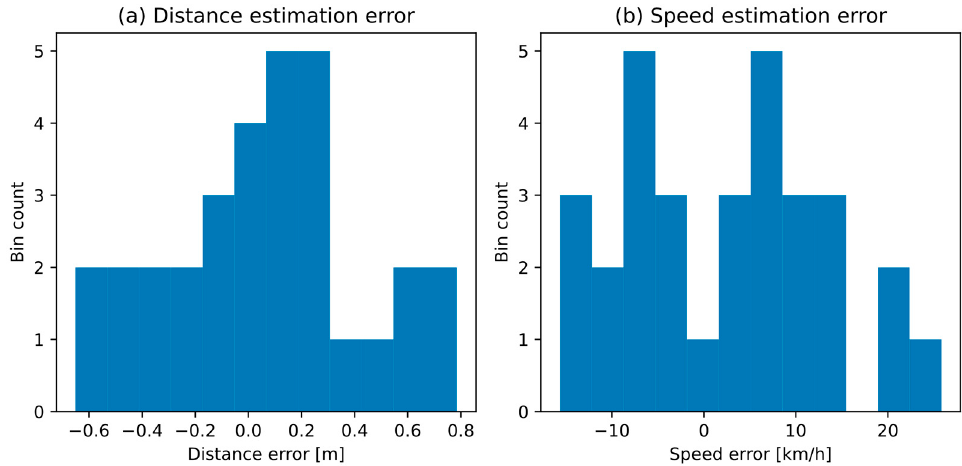
Figure 11. Histograms of estimation error for individual vehicles: ( a ) distance, ( b ) speed.